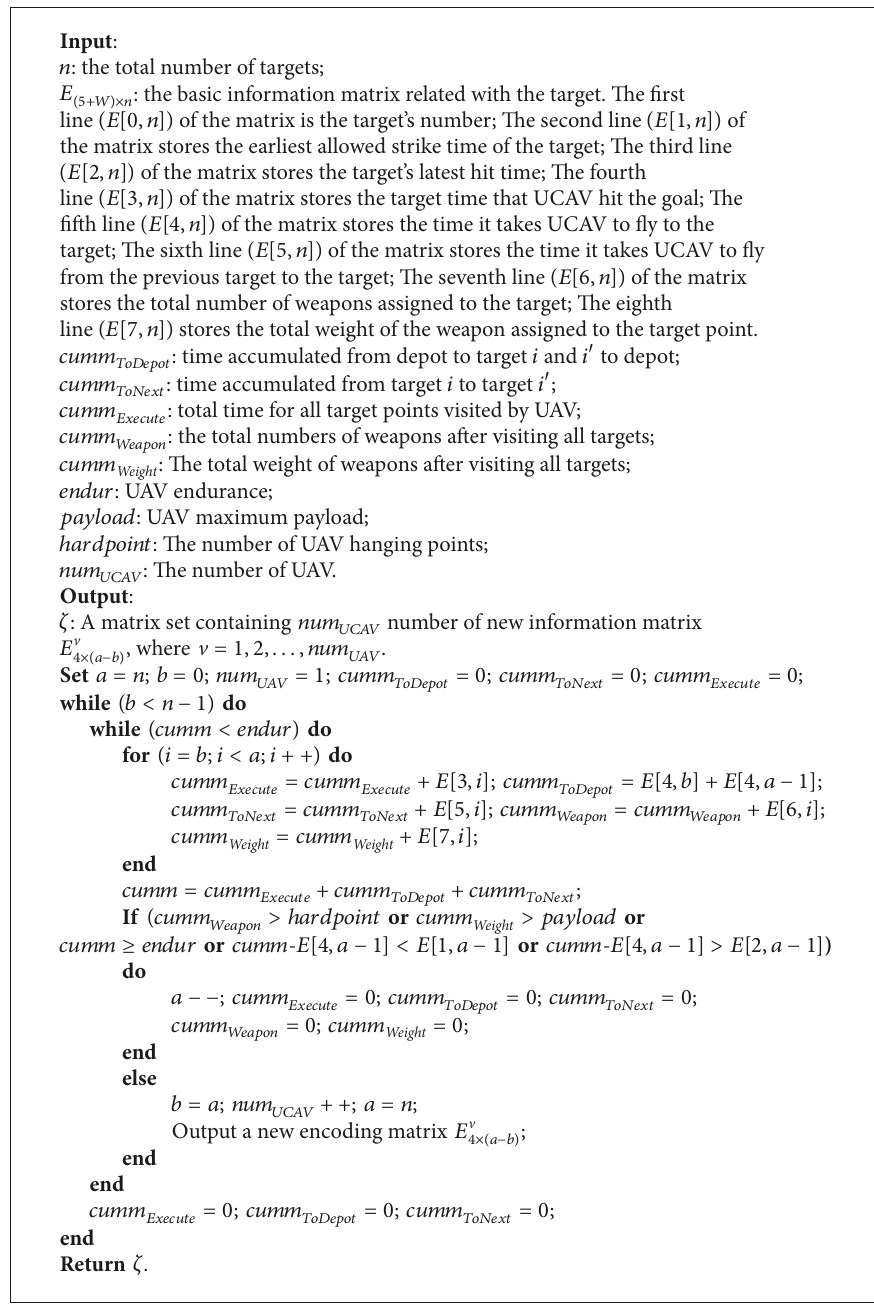
Algorithm 4: Procedure of the FRC